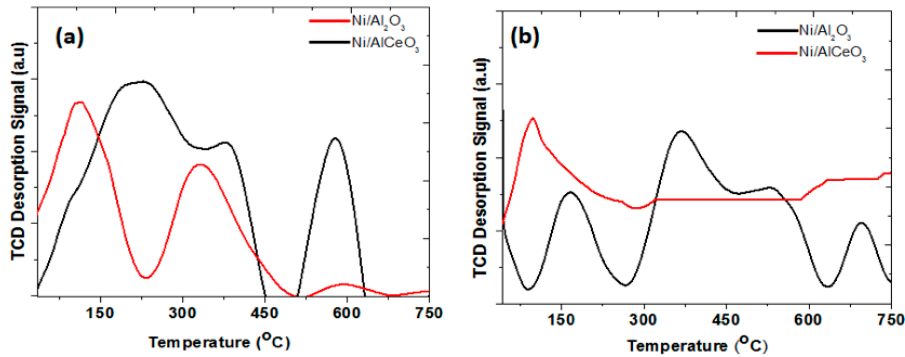
Figure 4. ( a ) CO 2 –TPD and ( b ) NH 3 –TPD profiles of the Ni/Al 2 O 3 and Ni/AlCeO 3 catalysts.